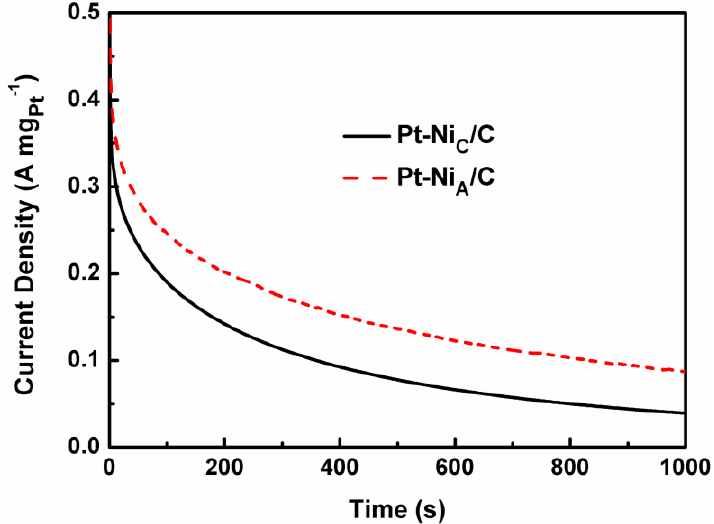
Figure 7. Chronoamperometric curves for methanol oxidation at 0.6 V vs. Ag/AgCl on Pt-Ni /C and Pt-Ni /C in 0.5 mol L −1 CH A C room